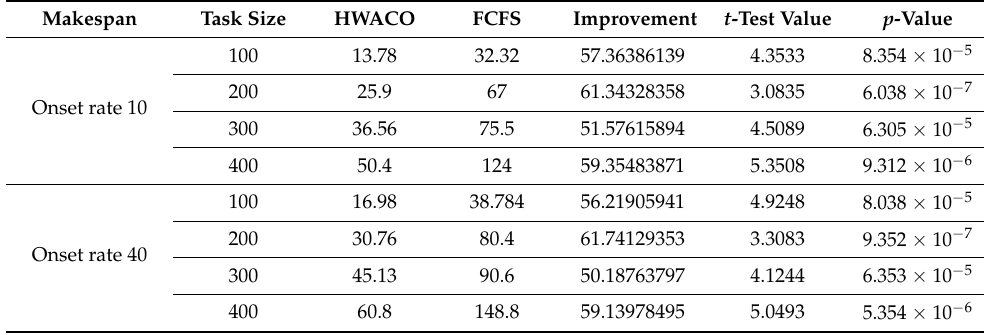
Table 8. t -Test for makespan between HWACO and